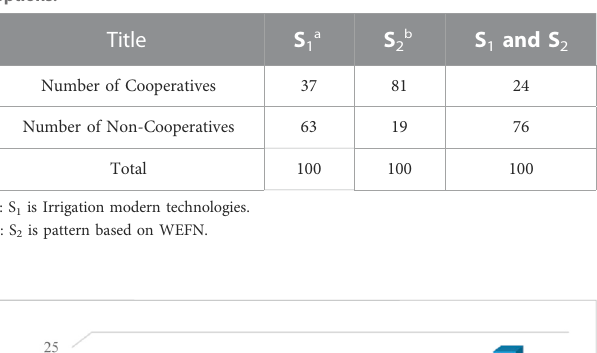
TABLE 6 The level of cooperation and non-cooperation of farmers with policy options.